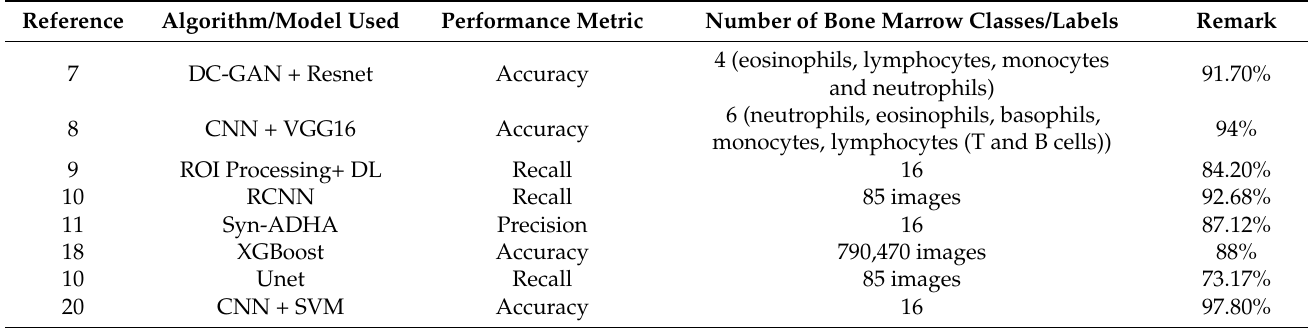
Table 1. A summary of the findings from other